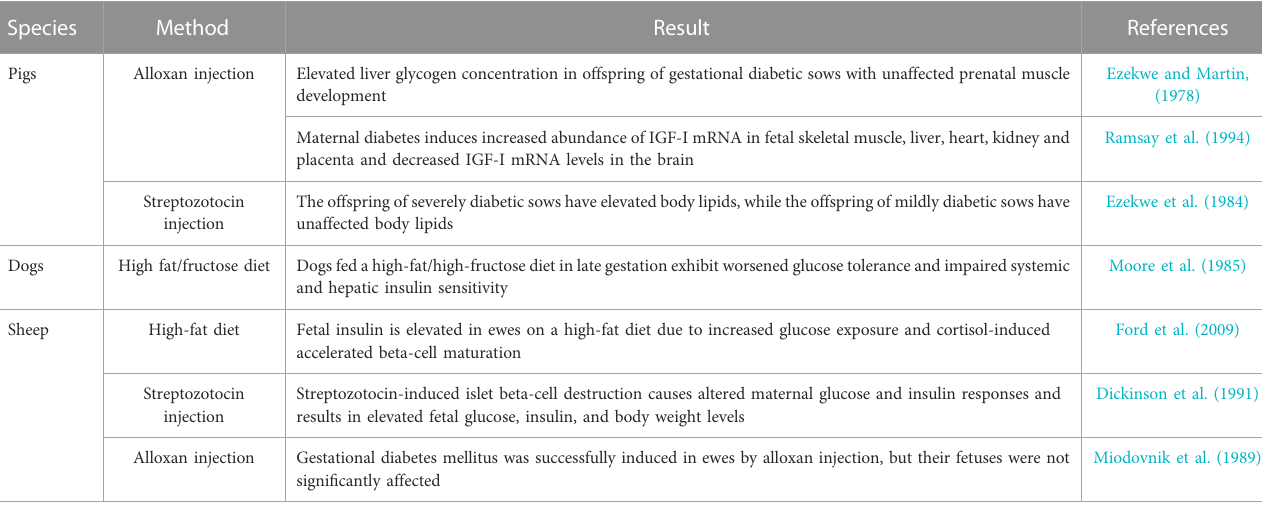
TABLE 2 Different large animals for the study of gestational